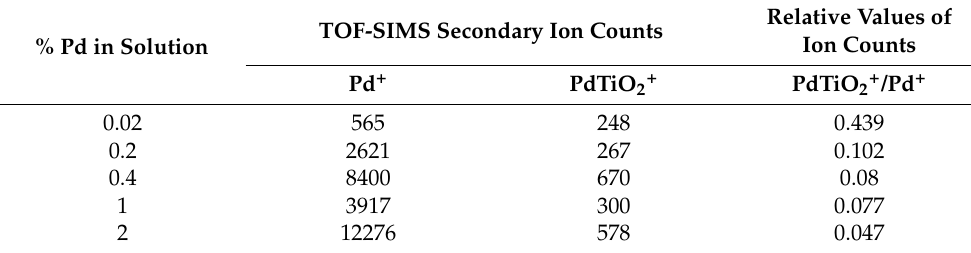
Table 2. Secondary ion counts for Pd/TiO 2